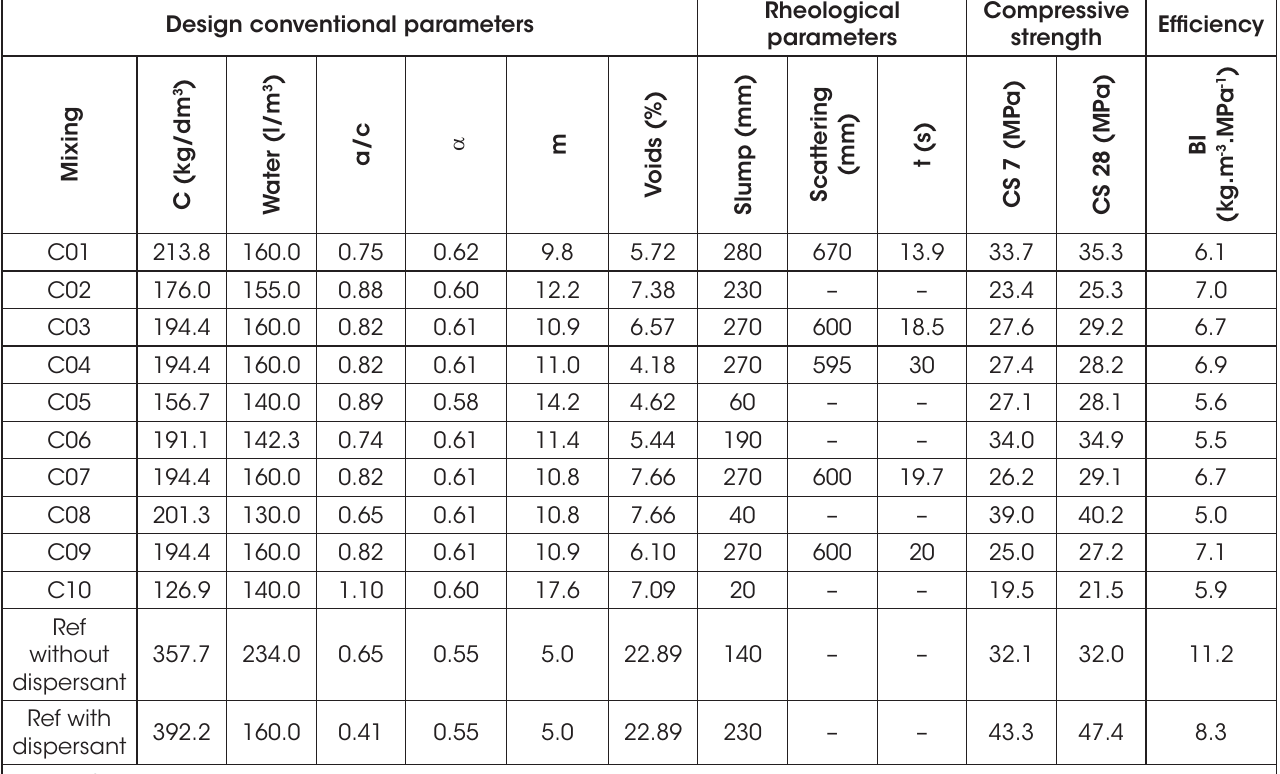
Rheological Compressive parameters